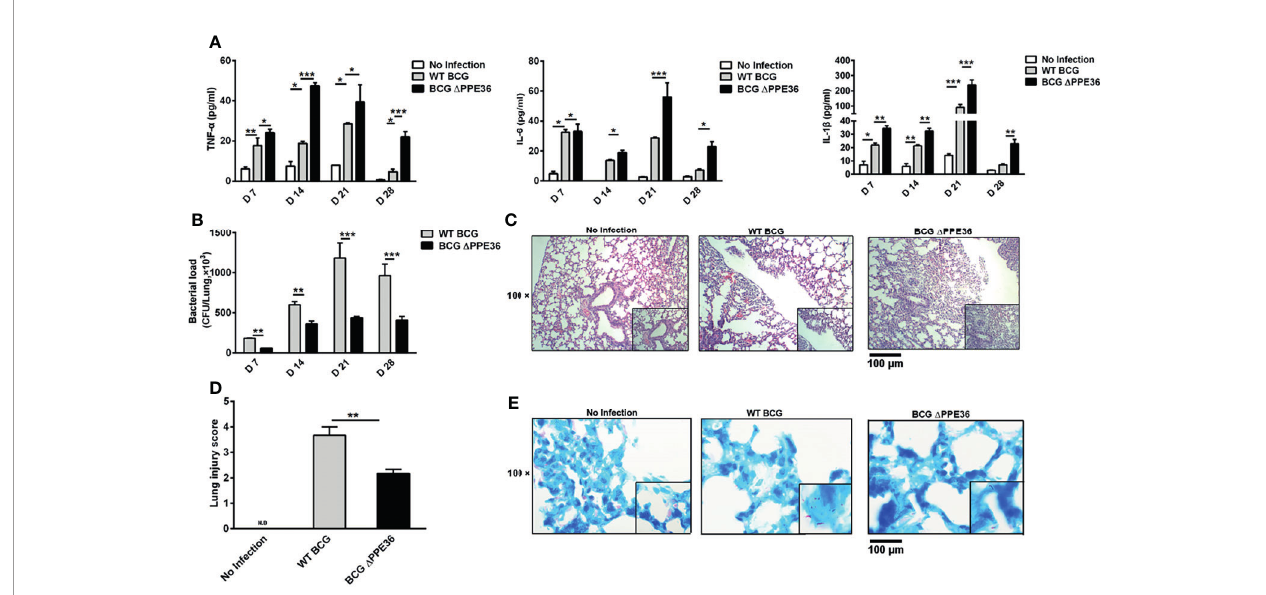
FIGURE 3 | PPE36 depletion led to the increased in fl ammation and decreased bacterial loads in the lungs of BCG infected mice. (A) Levels of in fl ammatory cytokines in lung tissues of mice infected with WT BCG or BCG D PPE36. (B) Bacterial loads in the lung tissues of infected mice. (C) Pathological observation of lung tissues of infected mice. (D) Lung injury scores of infected mice at day 28 postinfection. N.D, not detected. (E) Lung tissue sections from WT mice infected with WT BCG or BCG D PPE36 were analyzed with acid-fast staining. *p < 0.05, **p < 0.01, ***p